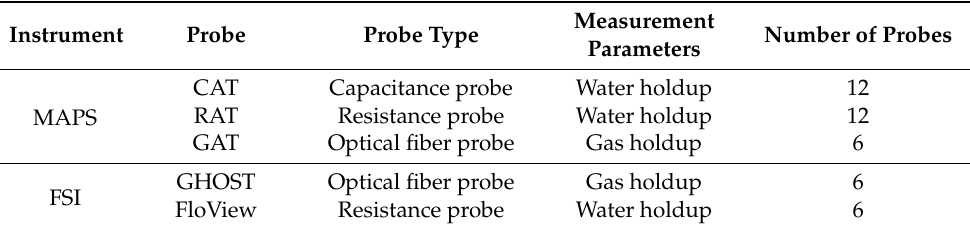
Table 1. Comparative analysis of Schlumberger’s FloScan Imager (FSI) and Multiple Array Production Suite (MAPS).